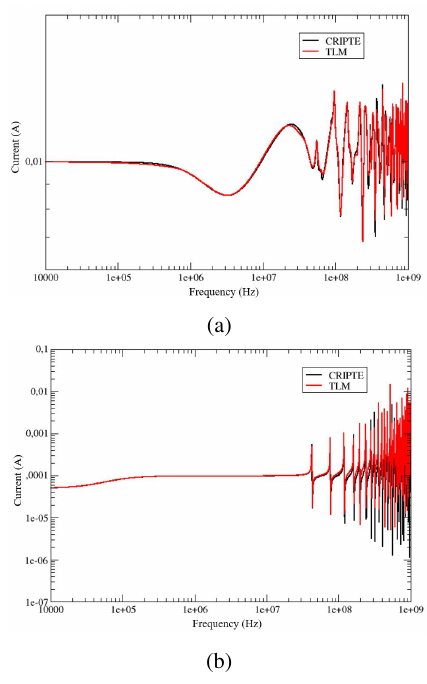
FIGURE 6: Current observed on wire 2 of tube T1 for the wiring network of Figure